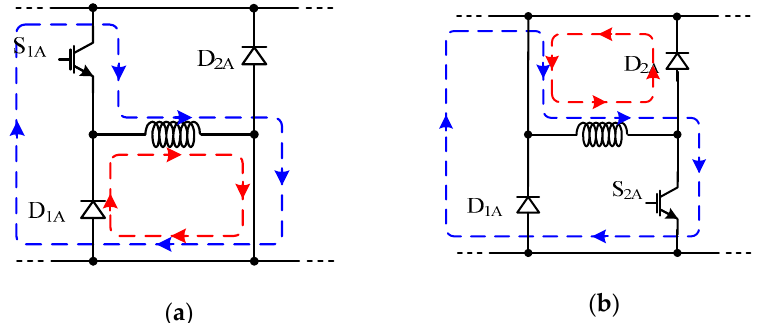
Figure 3. Current paths in the faulty bridge leg due to short-circuit failure in power device: ( a ) S 2 A , ( b ) S 1 A .